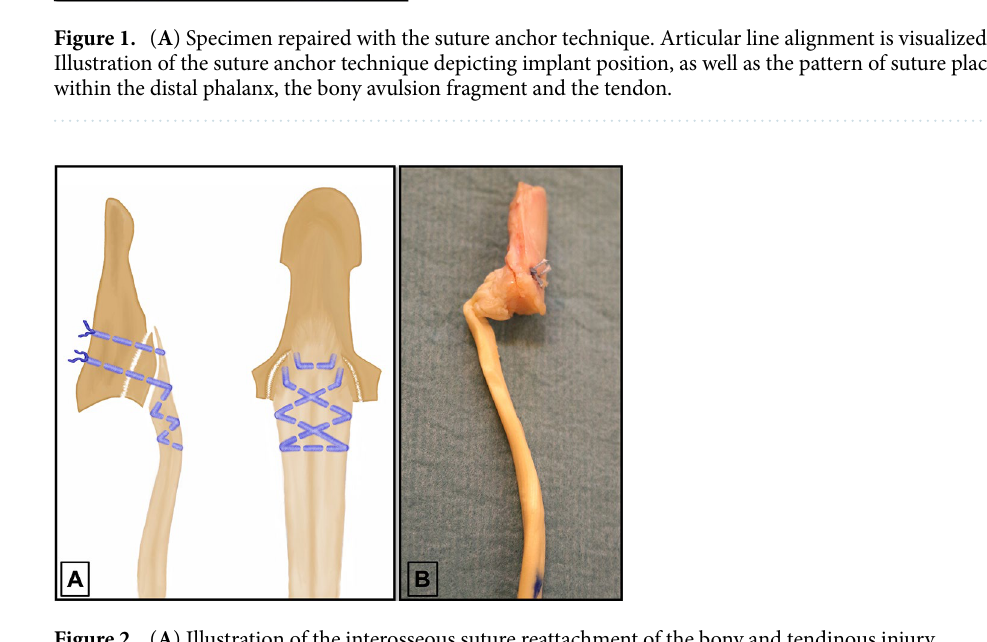
Figure 2. ( A ) Illustration of the interosseous suture reattachment of the bony and tendinous injury components. To allow a clear perception of the suture placement within the tendon and the avulsed bony fragment in the top view, dorsal aspects of the sutures are not depicted. ( B ) Photographic image of a specimen repaired with interosseous